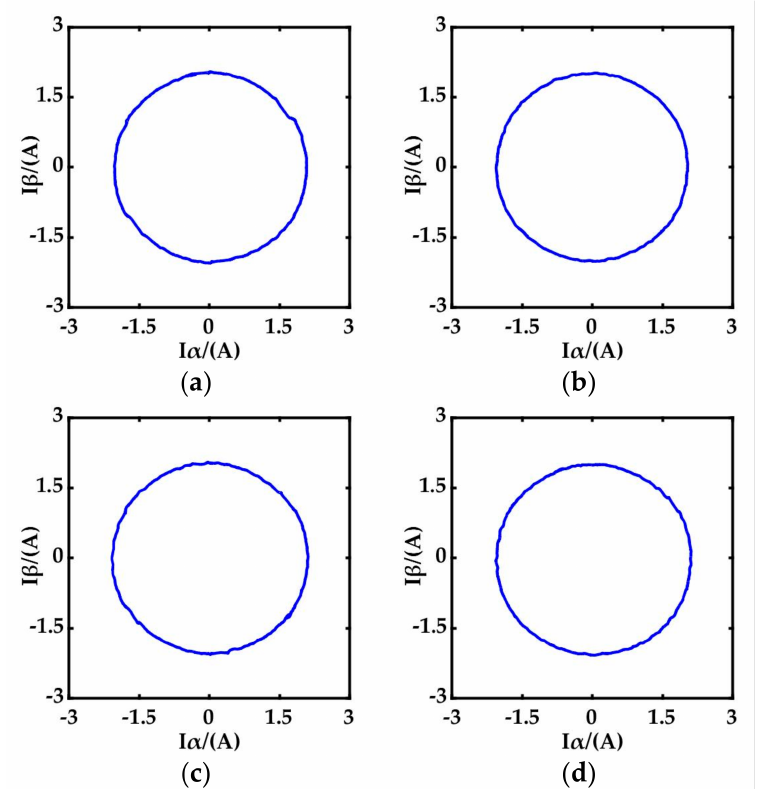
Figure 13. αβ –axis currents under i d = 0, 150 r/min and 1 N · m load. ( a ) Compensation for PMSM FOC system with conventional DM–CZD. ( b ) Compensation for PMSM FOC system with proposed DP–CZD. ( c ) Compensation for current predictive control of PMSM with conventional DM–CZD. ( d ) Compensation for current predictive control of PMSM with proposed DP–CZD.